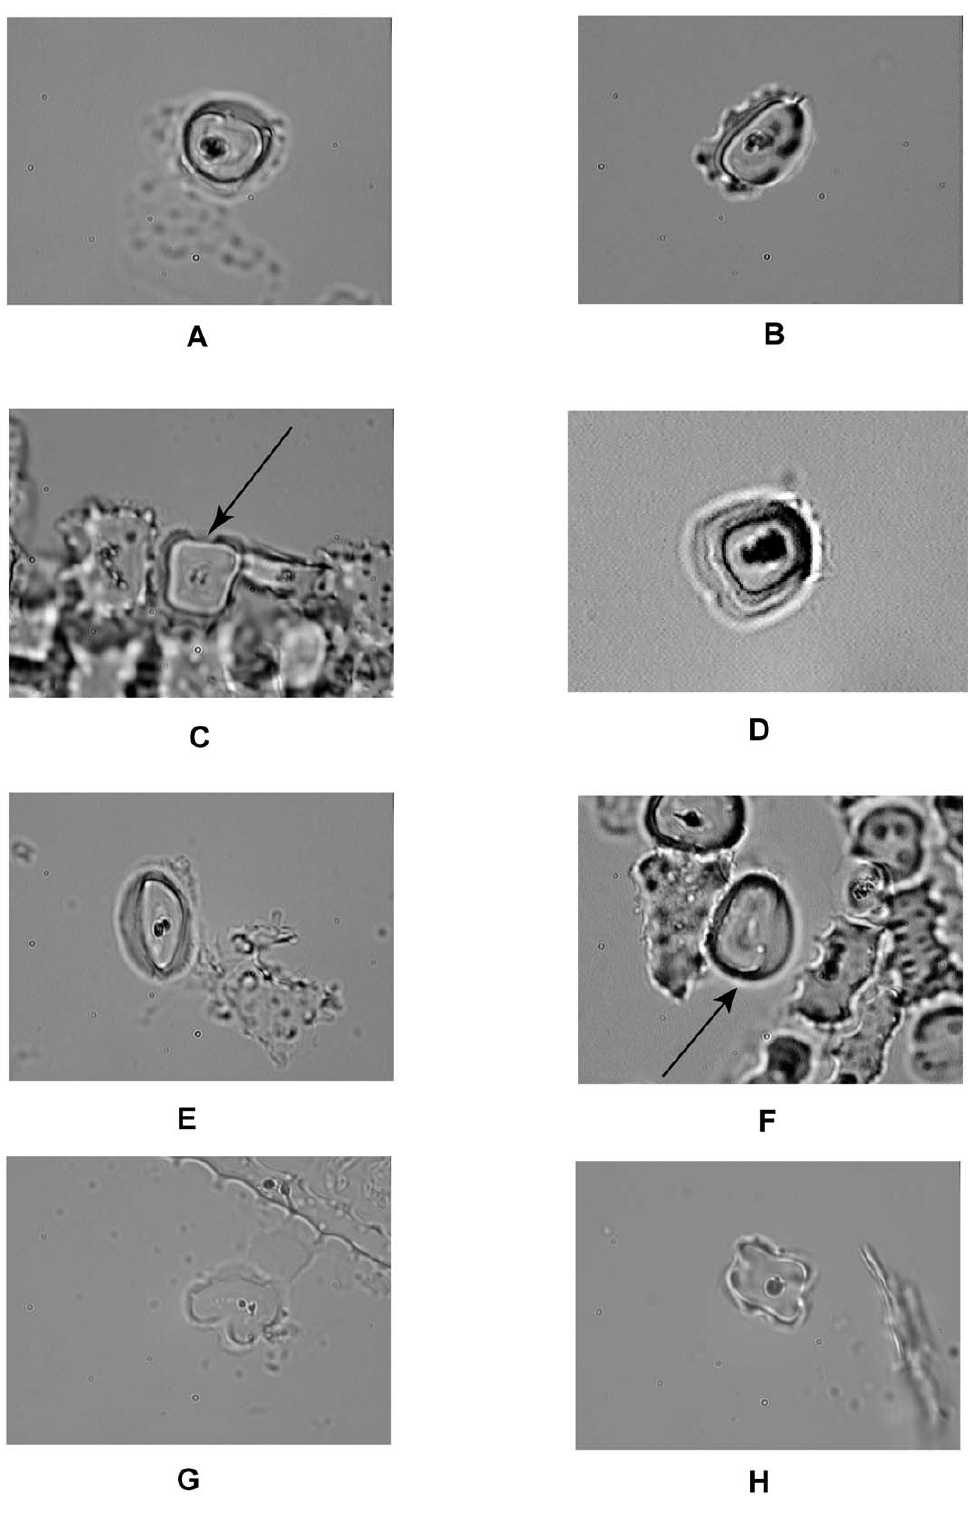
Figure 6. Photographs of representative of the important discriminating rondel phytolith categories listed in Table 5. Original magnification 1000 6 except D at 400 6 . Arrows in C and F indicate the phytolith belonging to the relevant category.